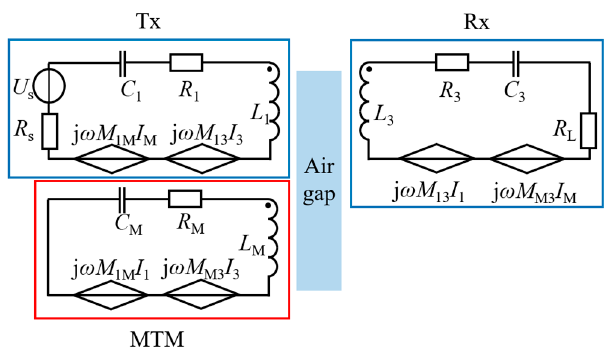
Figure 4. The proposed model for the MTM-enhanced wireless power transfer (WPT) system. M ij is the mutual inductance between coils and MTMs.